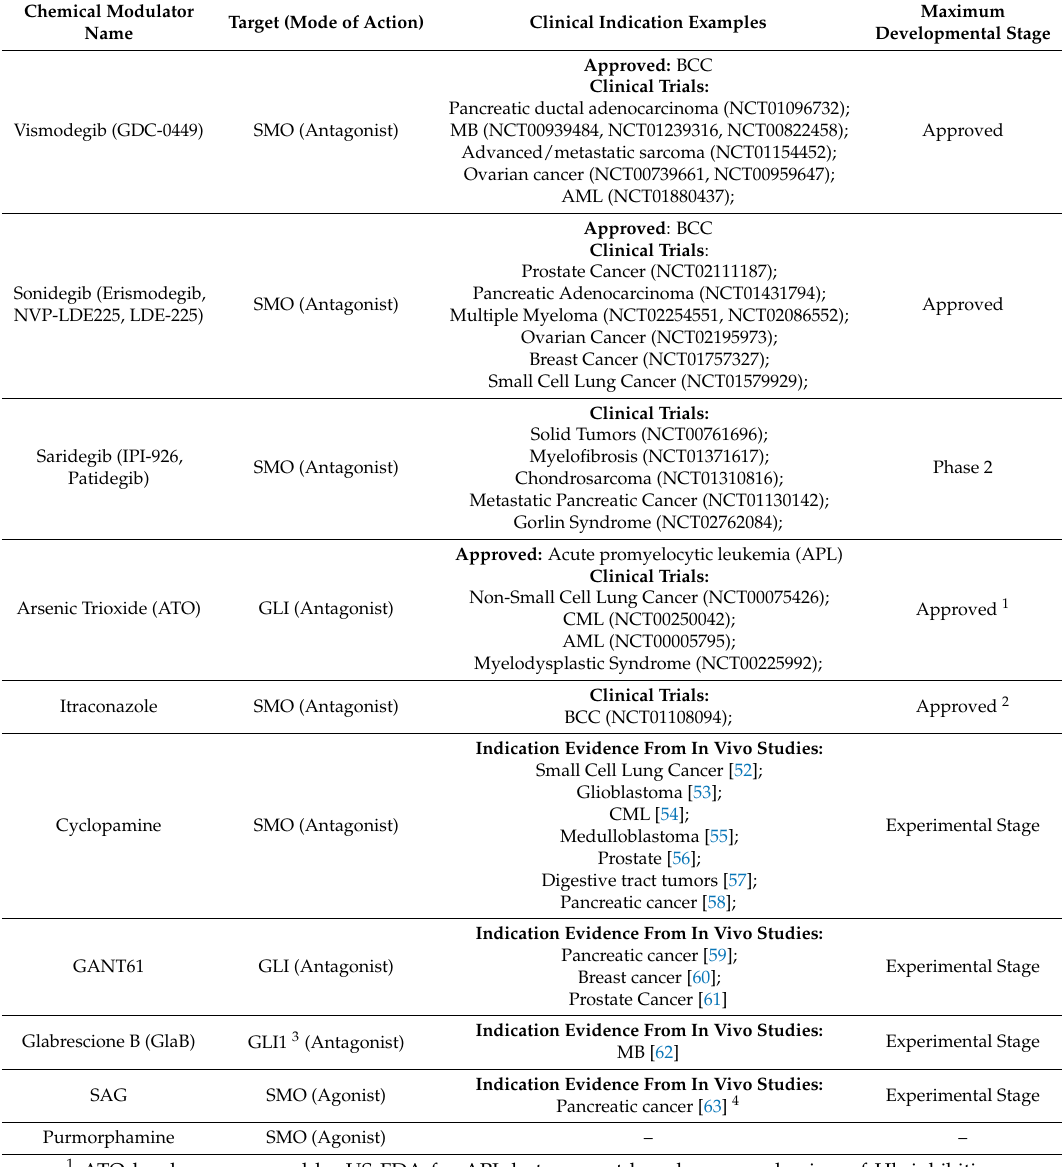
Table 3. Hh pathway modulators discussed in the current